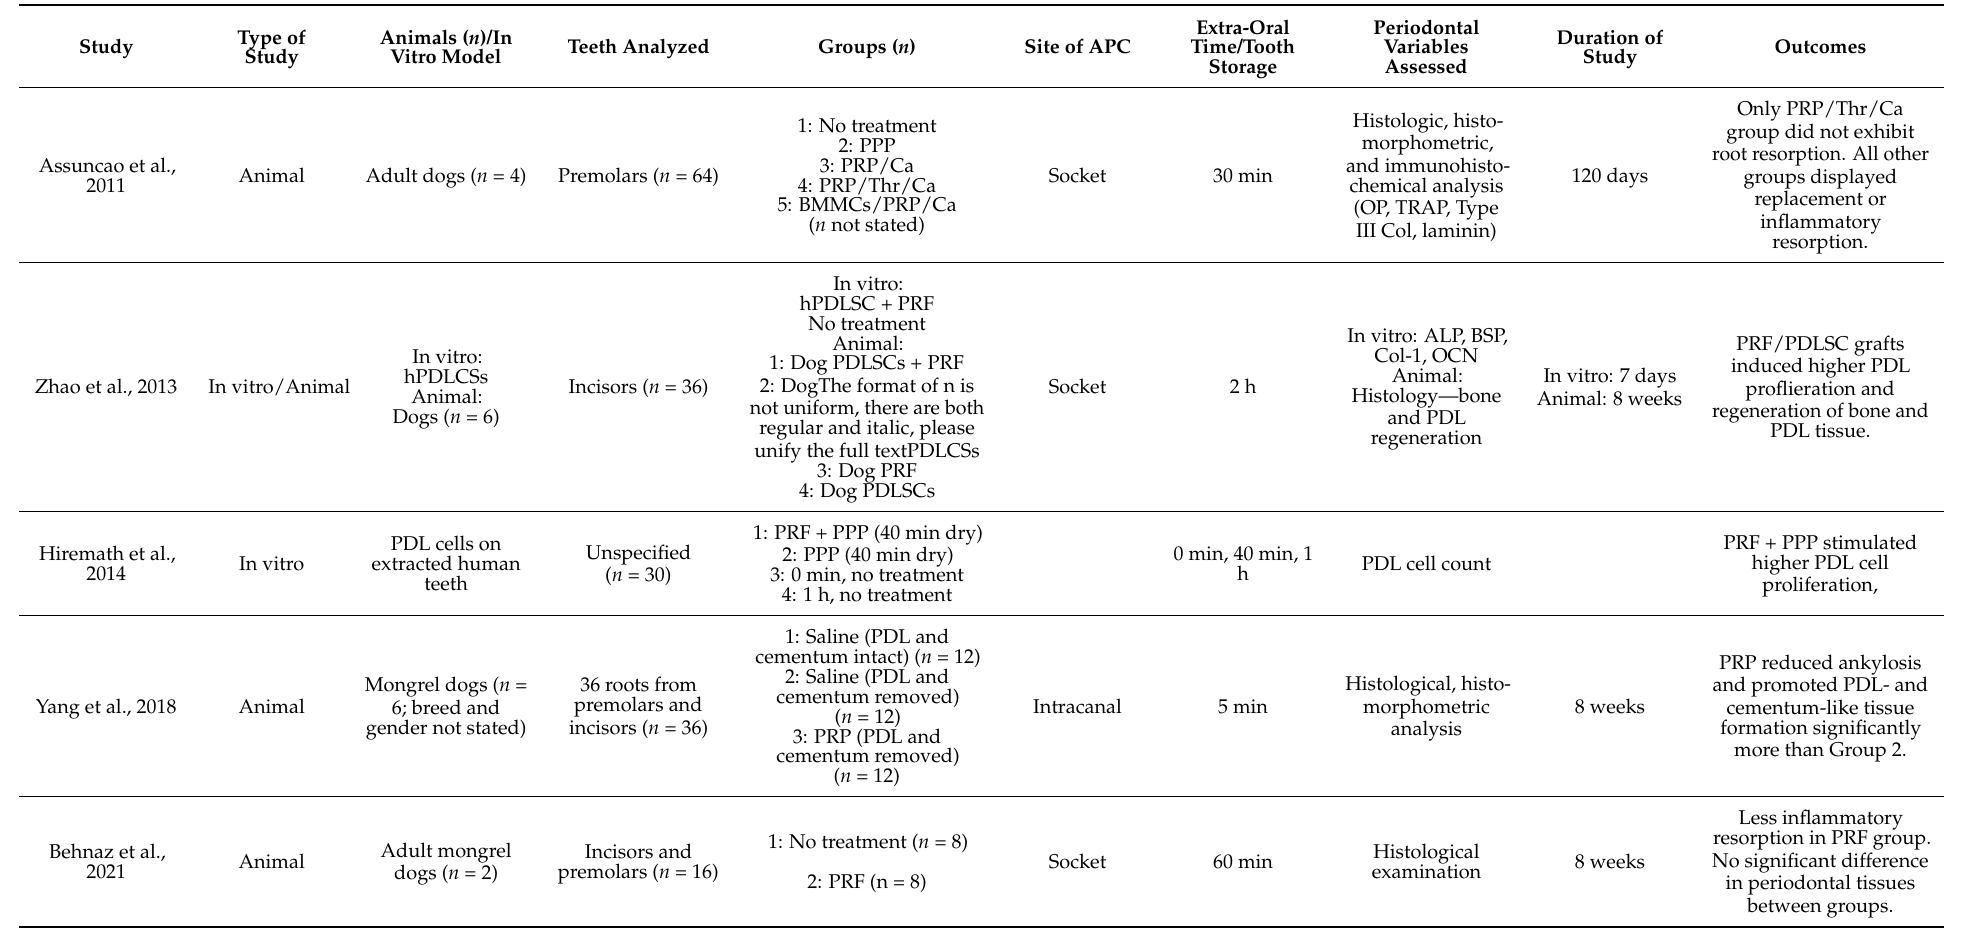
Table 2. General characteristics and outcomes of the animal studies and in vitro studies included in this